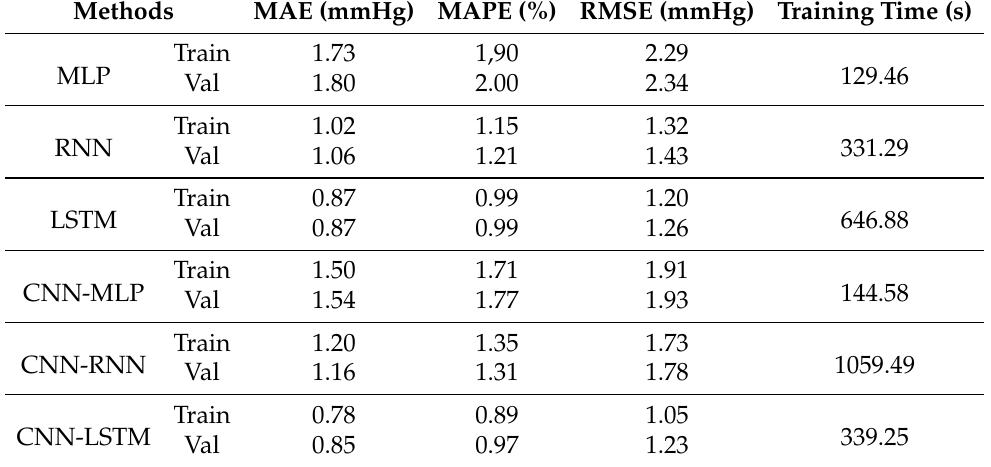
Table 6. Predicted performance of patient